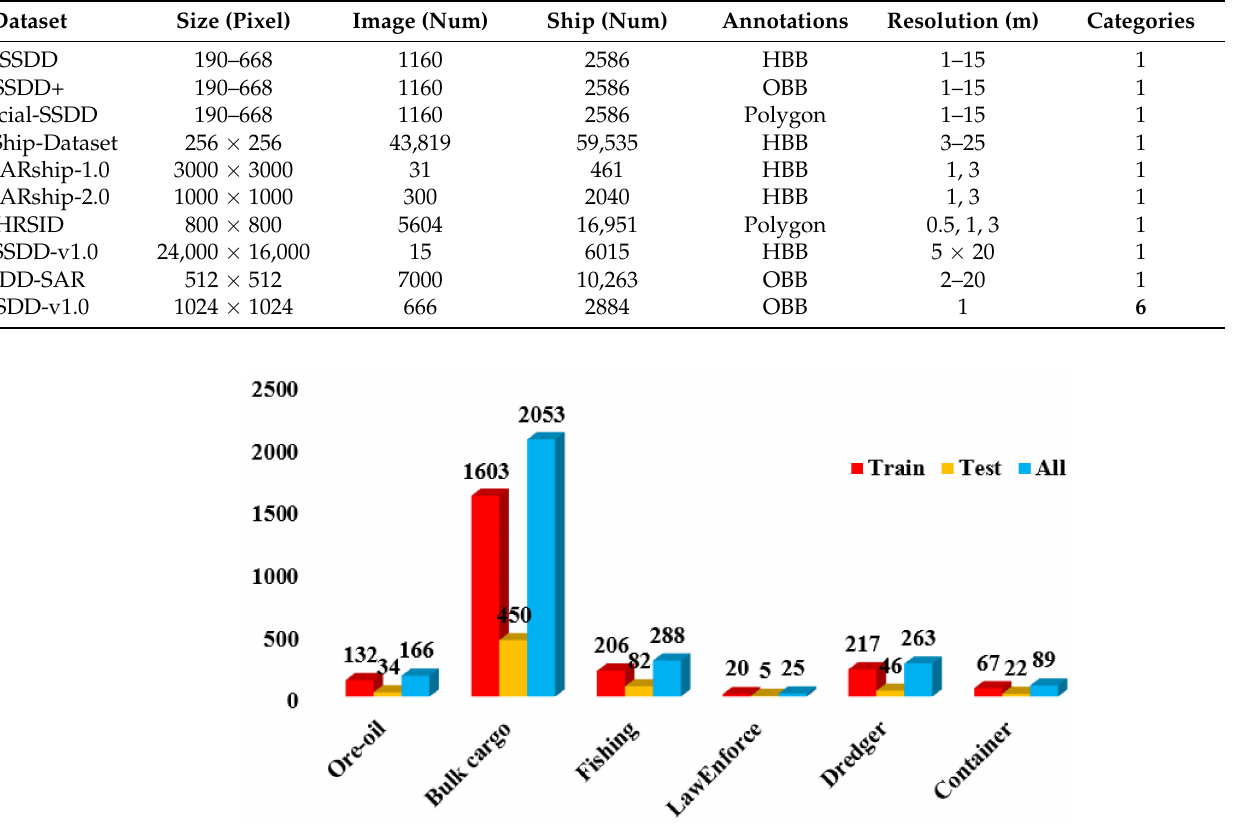
Figure 5. The quantity distributions of six categories of ships in SRSDD-v1.0